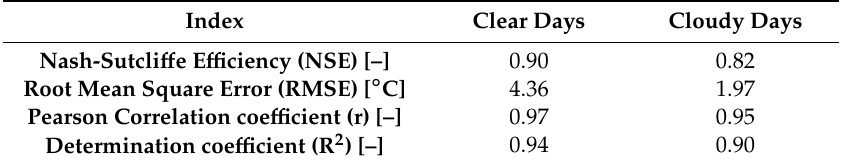
Table 9. Statistical indexes during clear and cloudy sky days between observed and simulated LST values by the MEC algorithm.